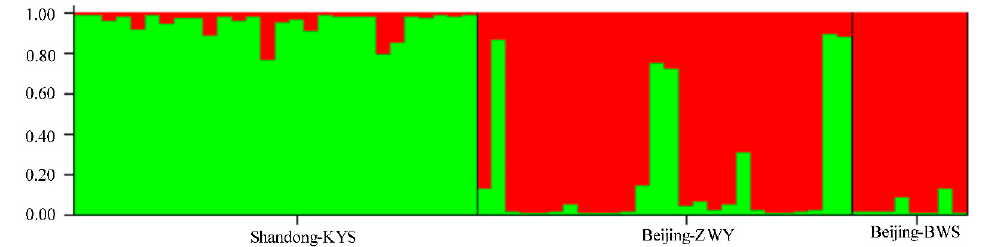
Table 2. Genetic diversity of Bombina orientalis populations based on microsatellite markers. Populatio